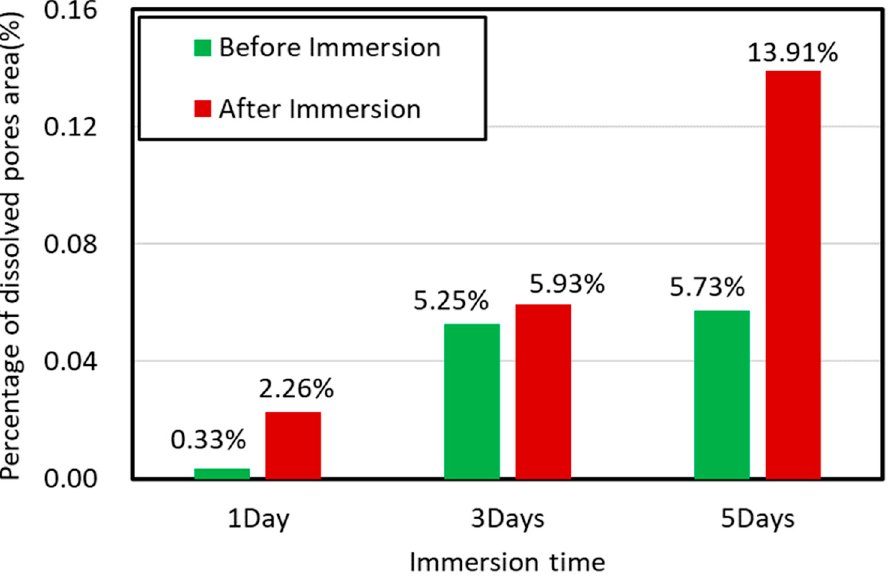
Figure 7. The percentage of dissolved pores area on sample surface varies with time at pressure of 3.5 Mpa and temperature of 80 °C.